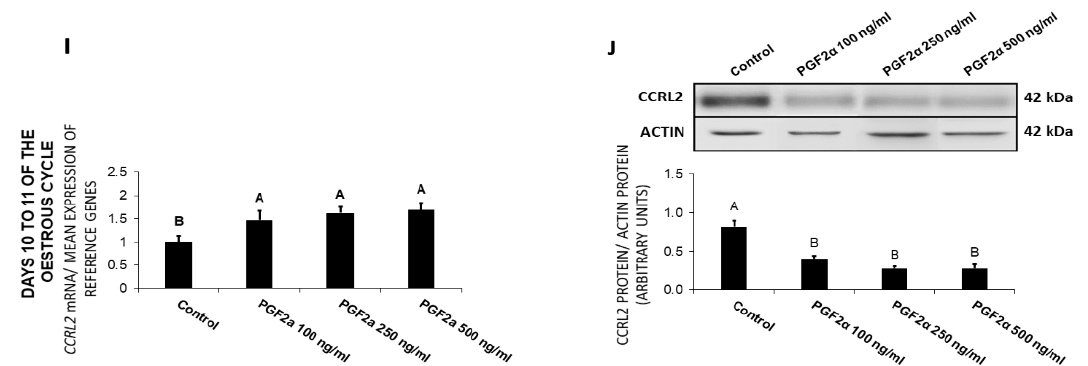
Figure 8 . The influence of prostaglandin F 2α (PGF 2α ; 100, 250, 500 ng/mL) on C-C motif chemokine receptor like 2 (CCRL2) mRNA ( A , C , E , G , I ) and protein ( B , D , F , H , J ) expression in the porcine endometrium on days 10 to 11, 12 to 13, 15 to 16, and 27 to 28 of the pregnancy, and on days 10 to 11 of the estrous cycle. The gene expression was determined by quantitative real-time PCR. The protein concentration was determined by the western blotting analysis; upper panels: Representative immunoblots; lower panels: Densitometric analysis of CCRL2 protein relative to actin protein. Results are reported as the means ± S.E.M. ( n = 5). Bars with di ff erent superscripts di ff er ( p <